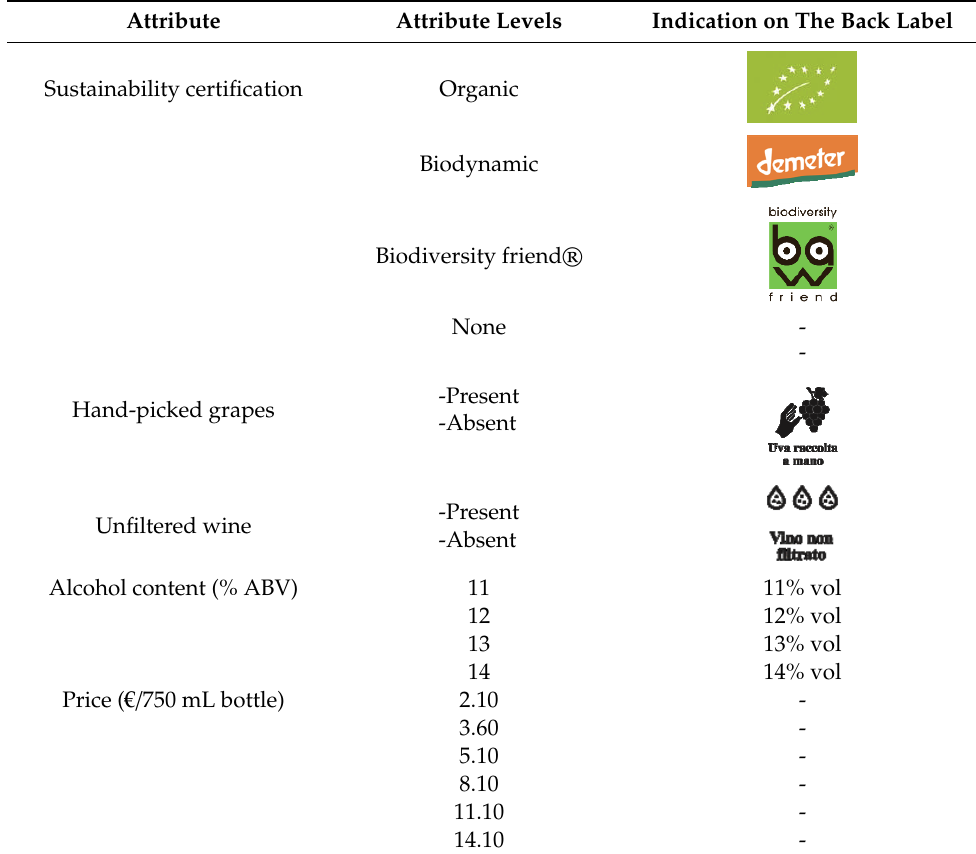
Table 1. Attributes and attribute levels used in the choice experiment.